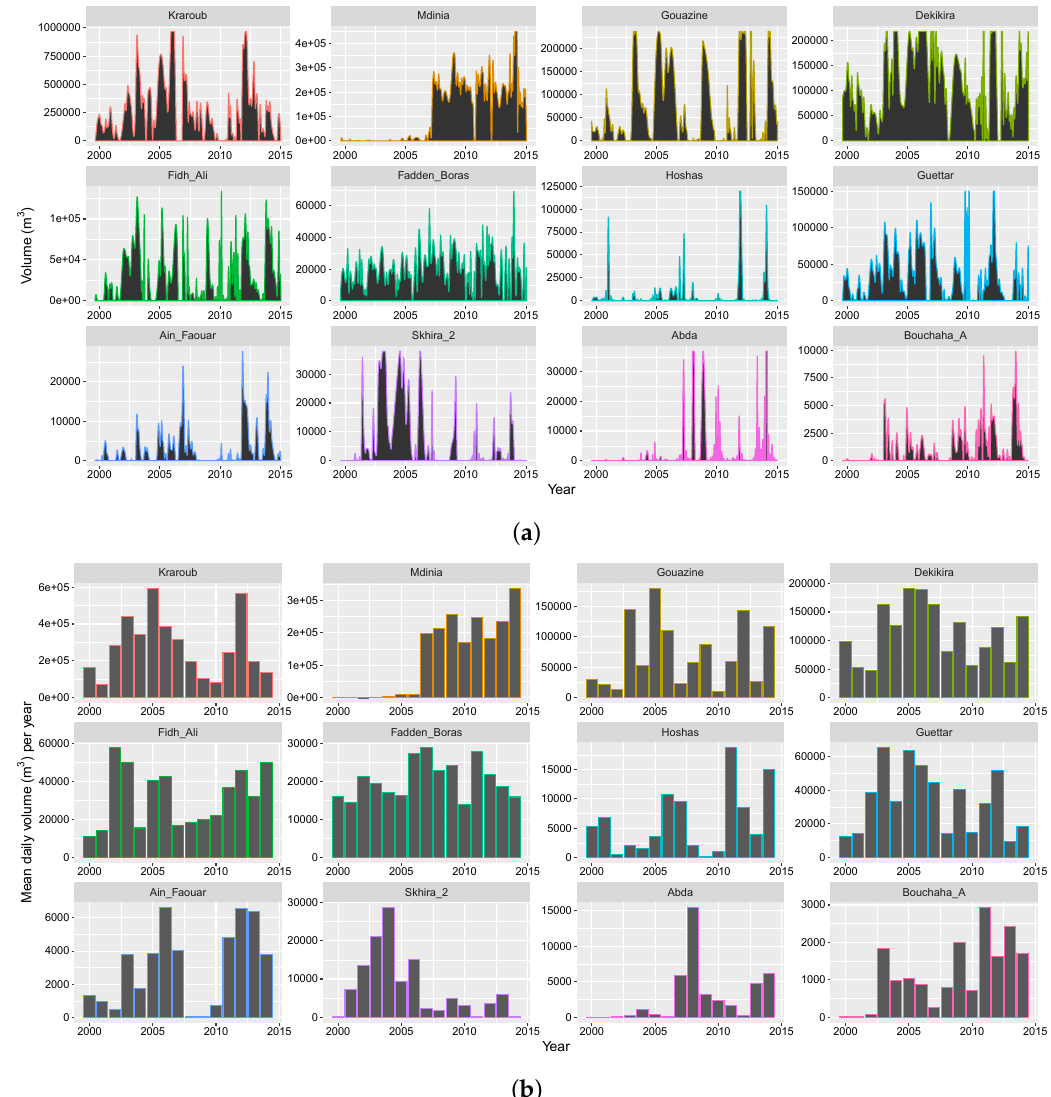
Figure 15. Landsat-derived volumes for the subset of 12 ungauged lakes over 1999–2014. ( a ) Daily volumes; ( b ) mean daily volumes per